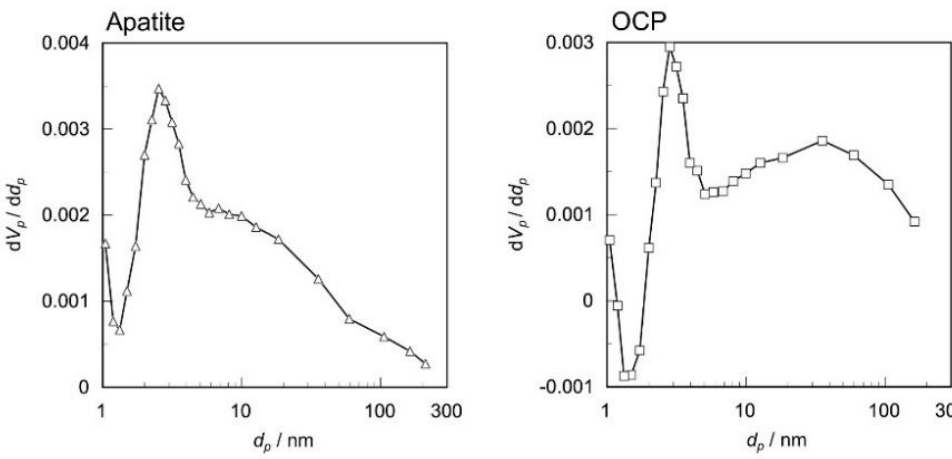
Figure 5. BJH pore size distribution of apatite and OCP microspheres. Figure 6 shows the appearance of OCP microspheres after immersion in the methy- lene blue solution and microspheres prepared with the addition of methylene blue. The microspheres prepared with methylene blue showed a darker blue color.